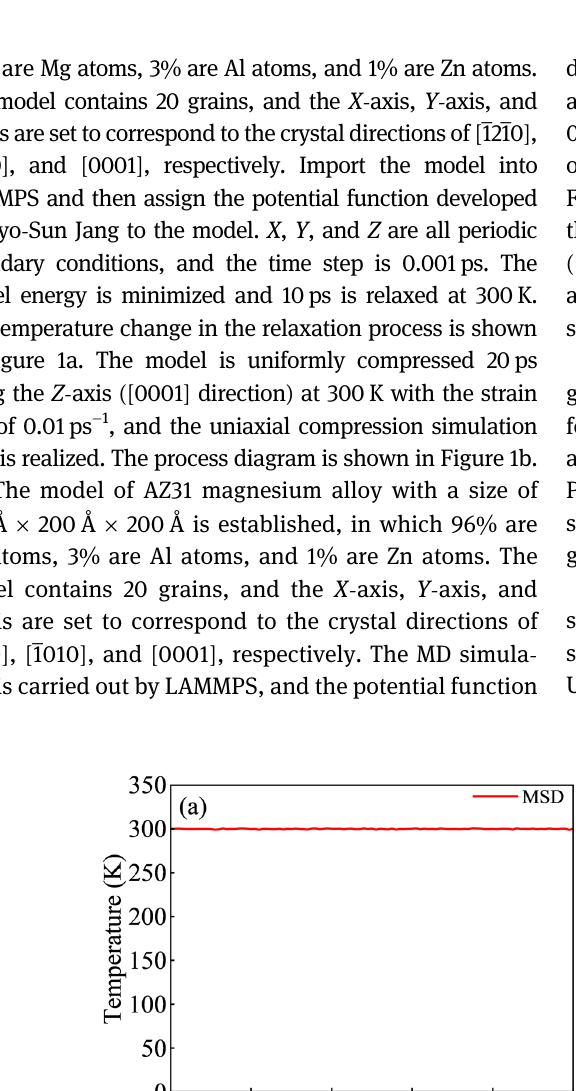
Figure 1: Uniaxial compression: ( a ) the change of temperature during relaxation and ( b ) process diagram.